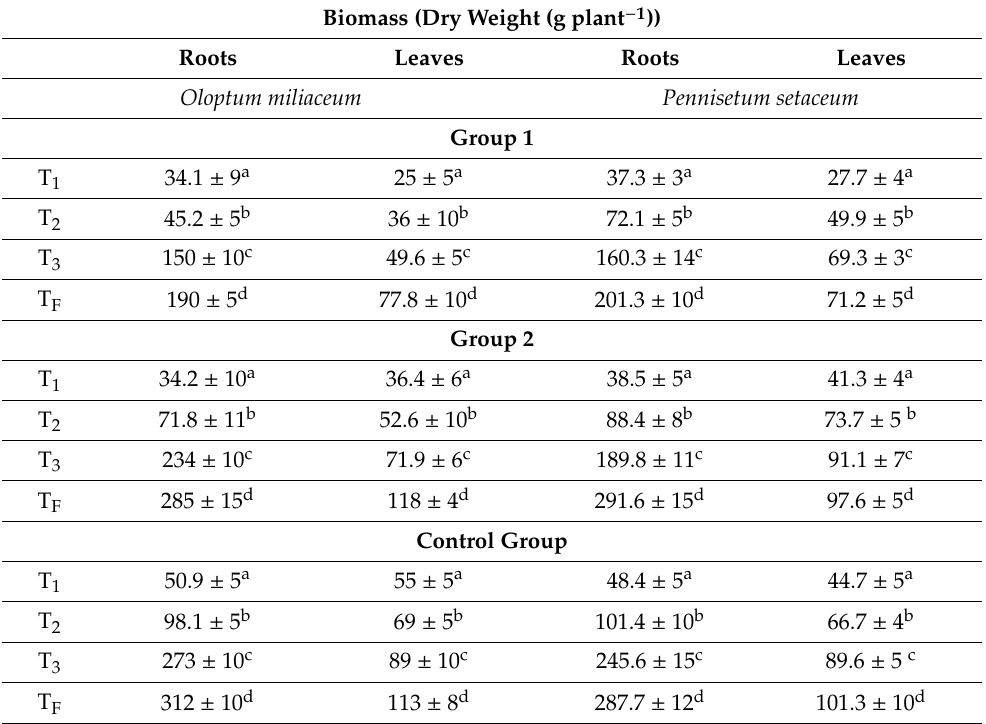
Table 2. Biomass (dry weight (g plant − 1 )) in roots and leaves of Oloptum miliaceum and Pennisetum setaceum for Group 1, 2, and Control Group after 30 (T 1 ), 60 (T 2 ), 90 (T 3 ), and 240 (T F ) days. Values represent mean ± SE. Di ff erent letters indicate means that are significantly di ff erent from each other (Duncan’s test, p <